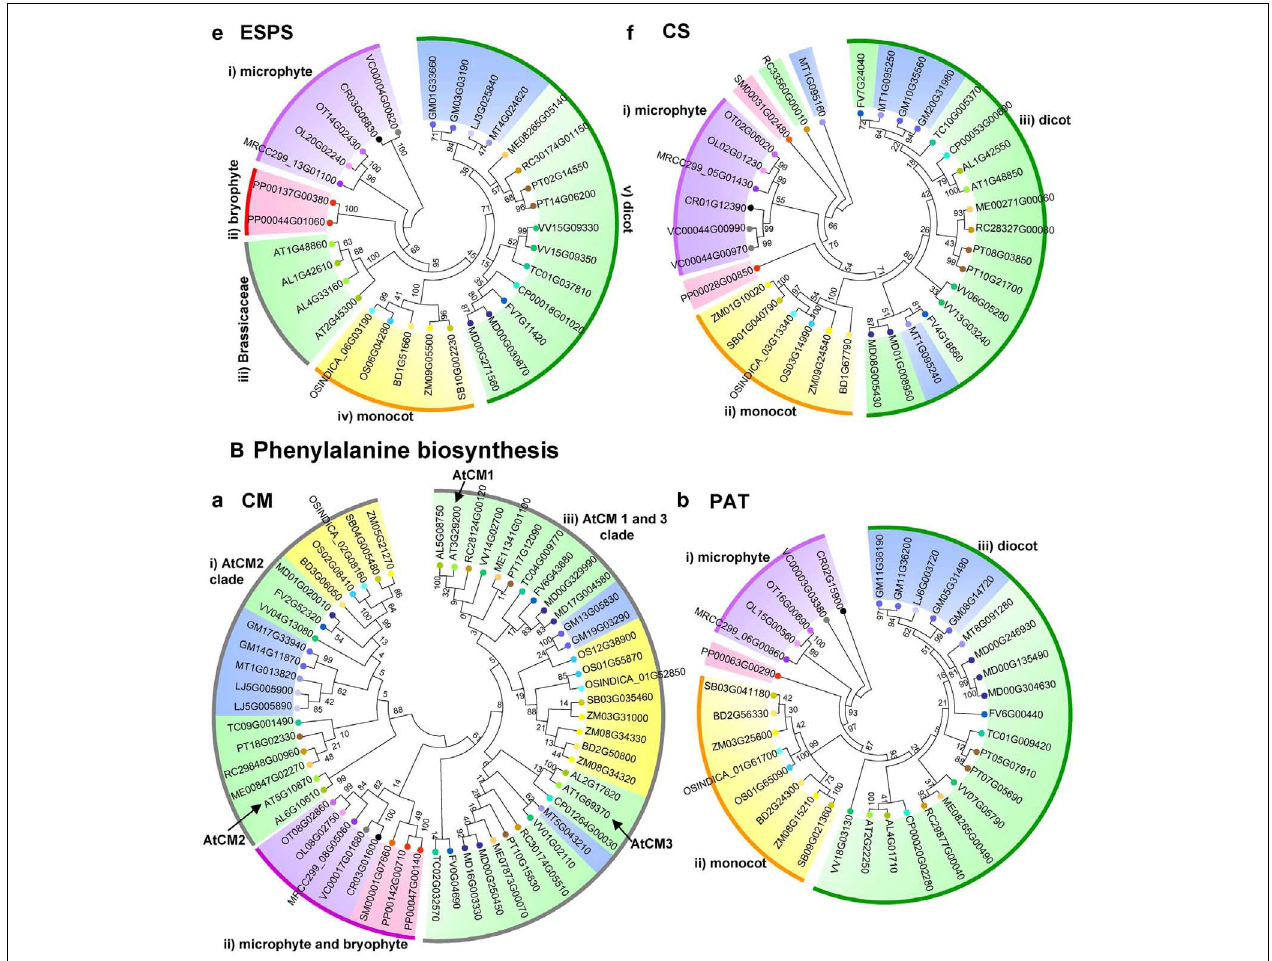
website.The phylogenetic tree was constructed with the aligned protein sequences by MEGA (version 5.10; http://www.megasoftware.net/; Kumar et al., 2004) using the neighbor-joining method with the following parameters: Poisson correction, complete deletion, and bootstrap (1000 replicates, random seed).The protein sequences were aligned by Plaza.Values on the branches indicate bootstrap support in